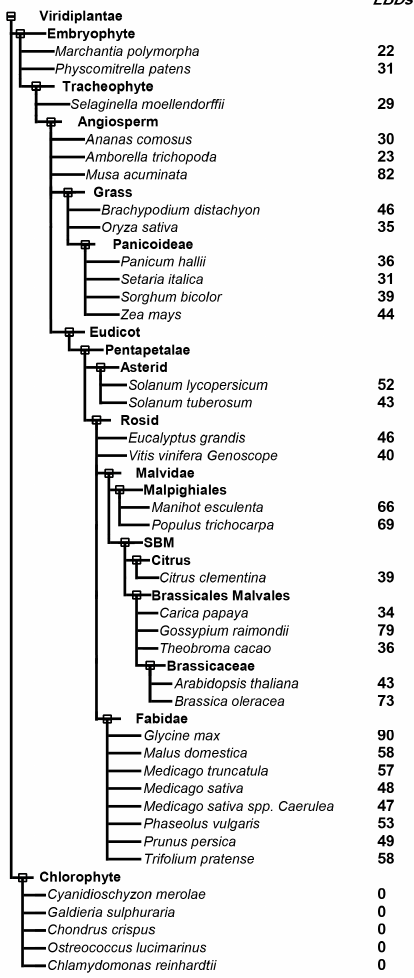
Figure 2. The number of LOB-domain like proteins in various plant species. The left panel shows a taxonomic tree of plant species in phytozomes from ensemble plants. The numbers indicate the LOB homologs.